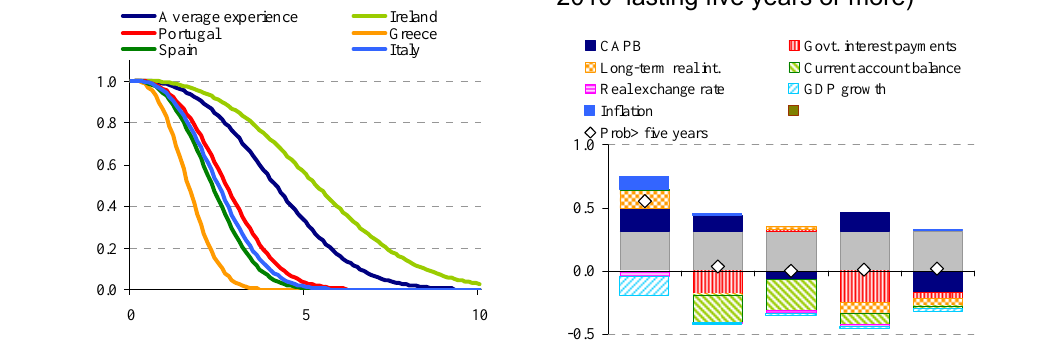
Figure 2: Estimated survivor curves for current fiscal consolidation efforts in